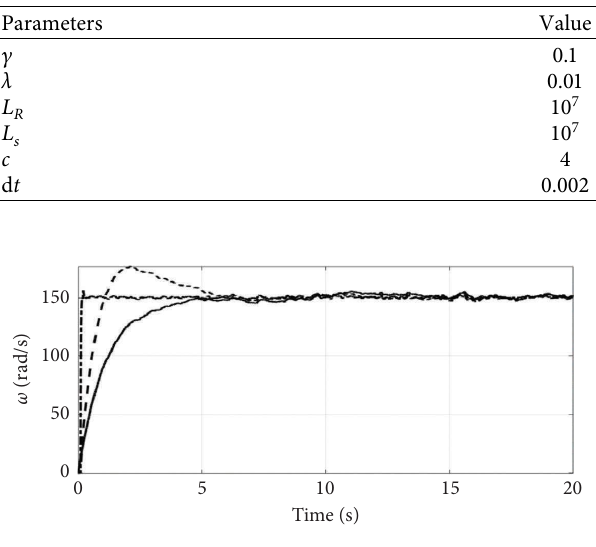
Table 6: Parameters for obtaining K and simulation for τ � 1s and stochastic disturbance.